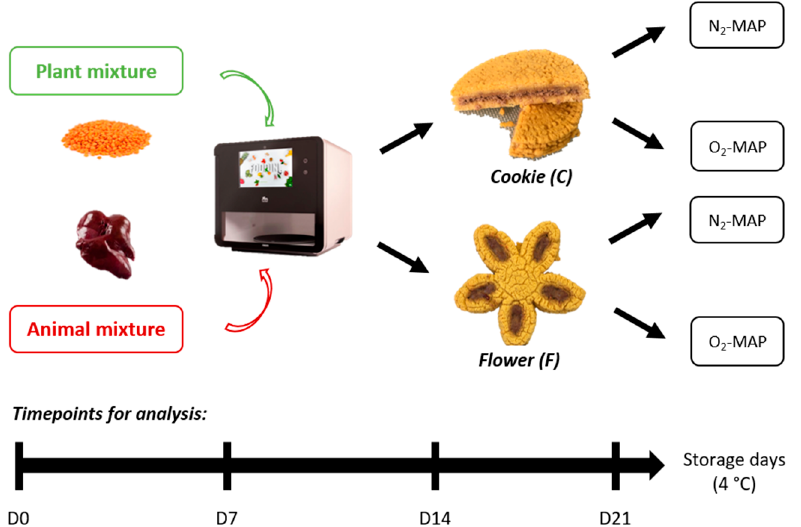
Figure 1. Schematic representation of the experiment illustrating the two printed forms studied (C and F) made from the two printable mixtures (plant mixture and animal mixture), their storage conditions (O 2 -MAP or N 2 -MAP; 4 °C), and the timepoints of the analyses performed (day 0 to 21). D: day.